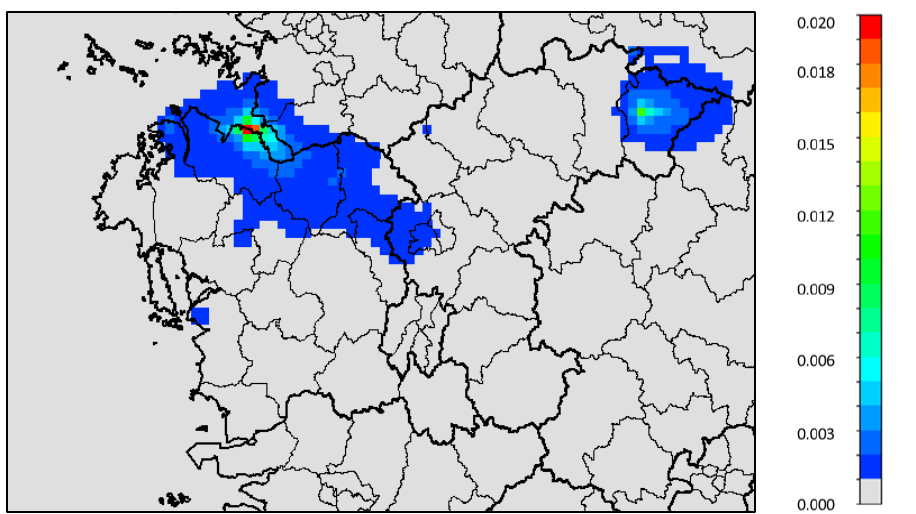
Figure 15. Monthly mean improvement of NOx concentration under S2 .